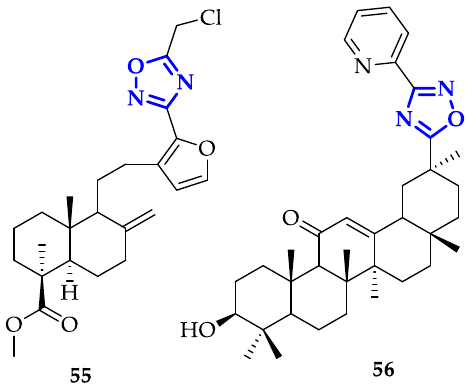
Figure 10. Oxadiazoles conjugated to bioactive molecules.